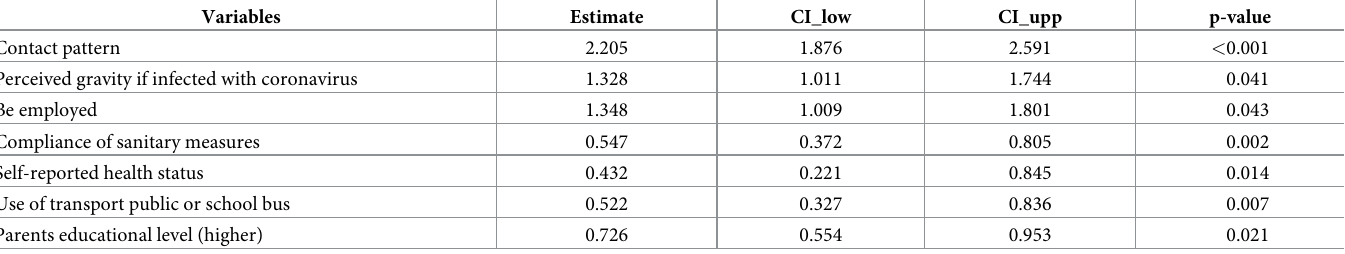
The variables included in the univariate analysis were also categorized into sociodemo- graphic and socioeconomic indicators, health status, and preventive compliance. There was a protective behavior associated with socioeconomic status, when comparing the highest level (high) in reference to the first tercile (low) (RR 0.25, 95% CI 0.06–0.96) for the COVID-19 infection (Table 9). C ontact with a suspected or confirmed case of COVID-19 , was a risk factor for infection (RR 6.44, 95% CI 3.15–13.19). When the contact occurred at home, the risk (RR 12.42, 95% CI Table 8. Multivariate analysis between SARS-CoV-2 infection, sociodemographic and health indicators, by students and staff from sentinel schools. Catalonia, Feb- ruary to March 2021.